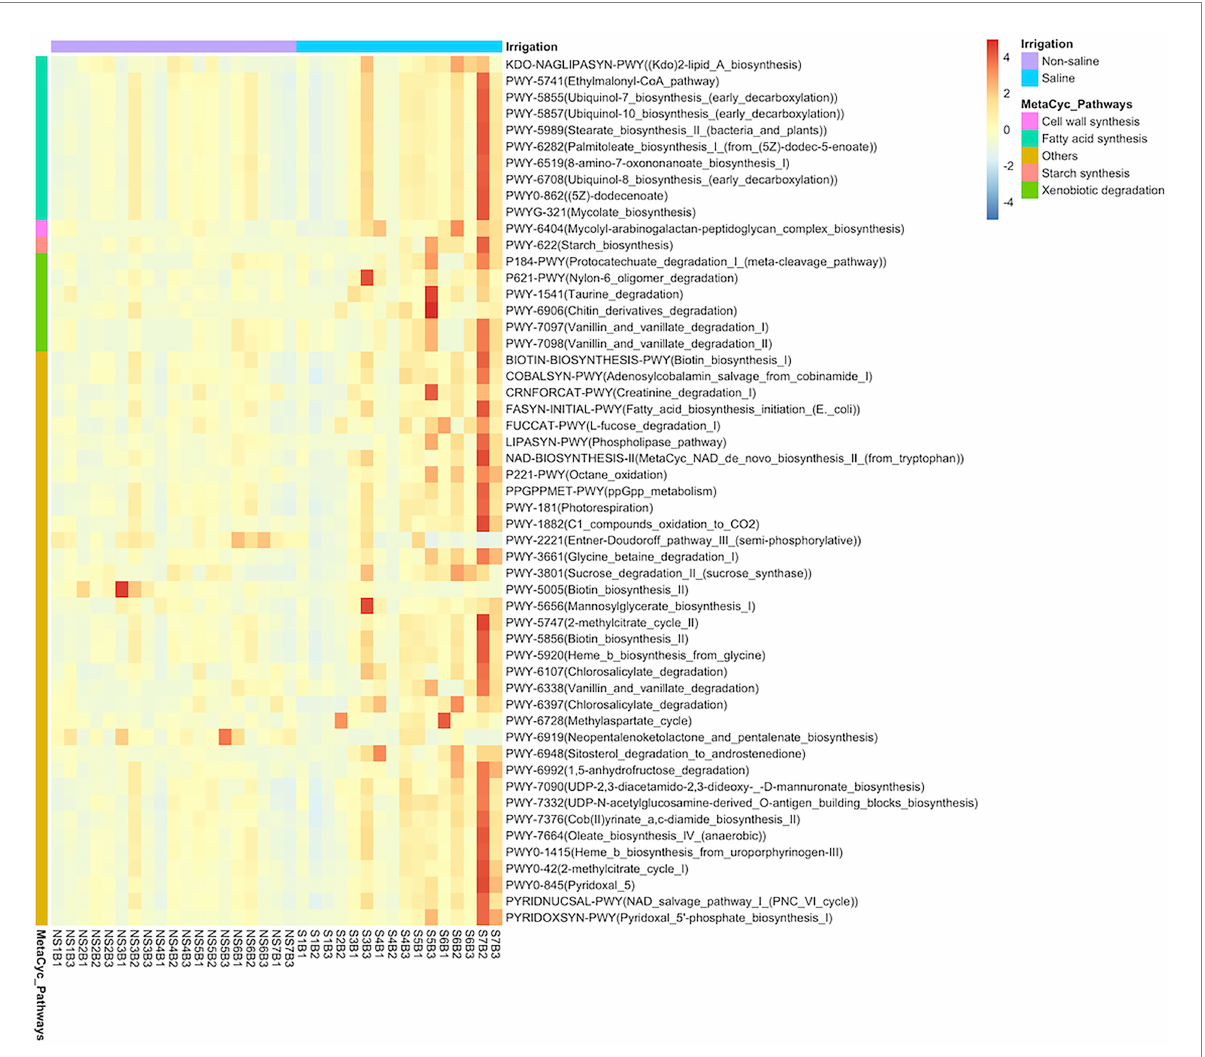
FIGURE 6 Heatmap analysis of predicted MetaCyc pathway abundances of bacterial OTUs. The heatmap shows significant predicted MetaCyc pathways ( p < 0.05) of bacteria in soil under different irrigation water sources (non-saline water vs. saline groundwater) using PICRUSt2 software. The MetaCyc pathways are grouped into categories and color key indicates the relative abundance of pathways on a scale of − 4 to